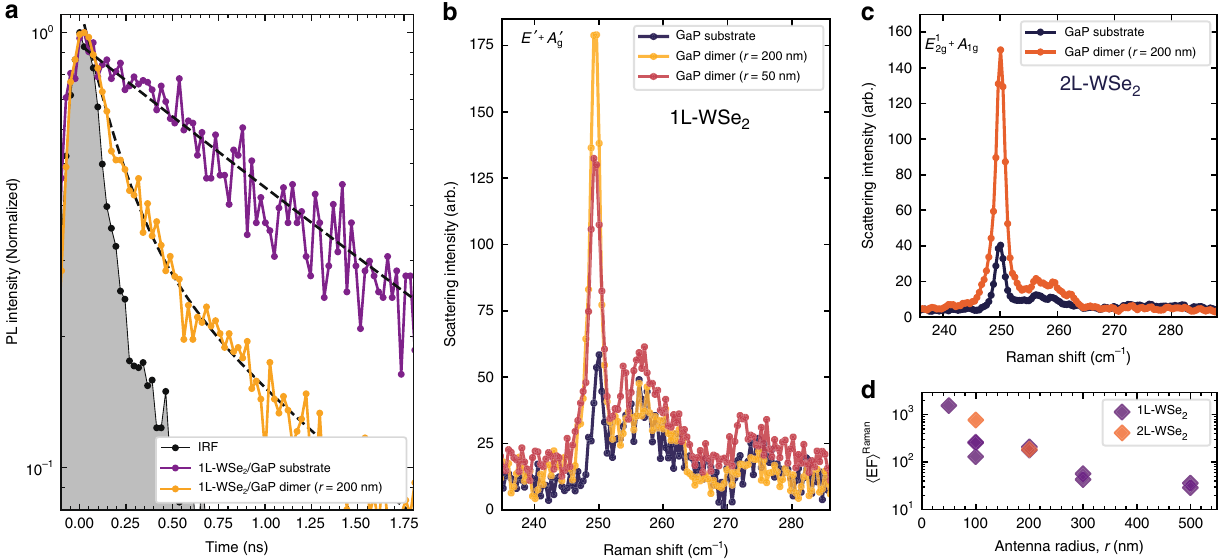
Fig. 4 Time-resolved photoluminescence and Raman scattering spectra. a PL decay traces for a WSe 2 monolayer placed on a planar GaP substrate (purple) and coupled to a nano-antenna with r ¼ 200 nm (yellow). Grey shows the instrument response function (IRF). The PL signal is measured with a 90-ps pulsed laser, under low excitation power of 0.2 W/cm 2 , to avoid exciton – exciton annihilation processes. Resolution-limited dynamics are measured for coupled to a dimer. Dotted black lines show results of the fi tting with exponential decay. b Raman scattering spectra for 1L-WSe WSe 2 nano-antennas with r = 50 nm (red) and 200 nm (yellow) and on the planar GaP (black). c Raman scattering spectra for 2L-WSe 2 on a r = 200 nm GaP nano-antenna (orange) and on the planar GaP (black). d Experimental Raman enhancement factor, h EF i Raman (see Eq. (3) in ‘ Methods ’ ), obtained (after background subtraction) for the 250 cm (cid:2) 1 peak in 1L- and 2L-WSe 2 coupled to nano-antennas with various